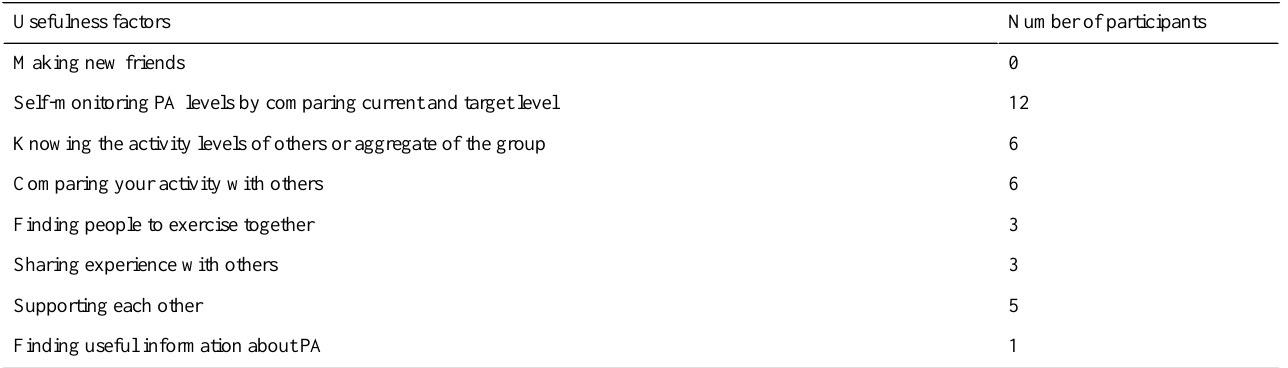
Table 8. Reported usefulness